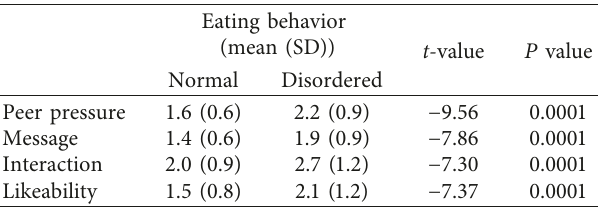
Table 5: Association of eating behaviors with the perception of peer pressure in school students in northern Jordan ( N � 738).